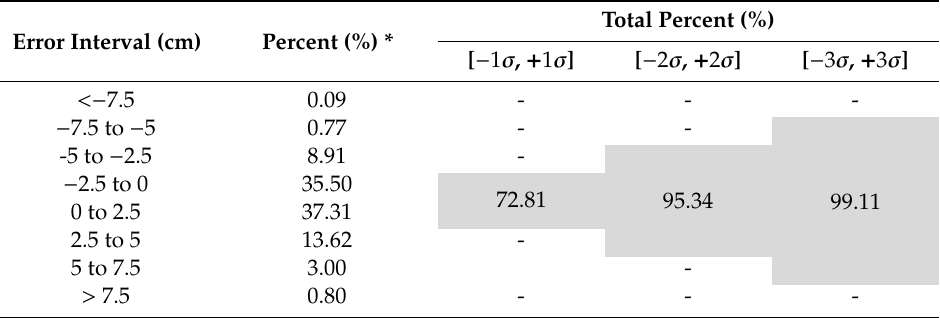
Figure 12. ( a ) Differences of elevations (NAVD88) between individual GPS points and their corresponding DEM grids derived from the georeferenced TLS points. ( b ) Histogram of elevation differences. Table 3. The distribution of differences (errors) between elevations derived from kinematic GPS measurements and TLS-derived DEMs.